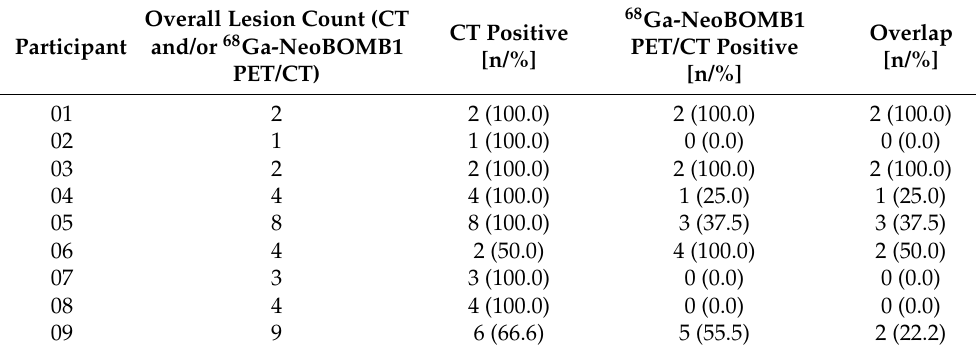
Table 2. CT and 68 Ga-NeoBOMB1 lesion detection